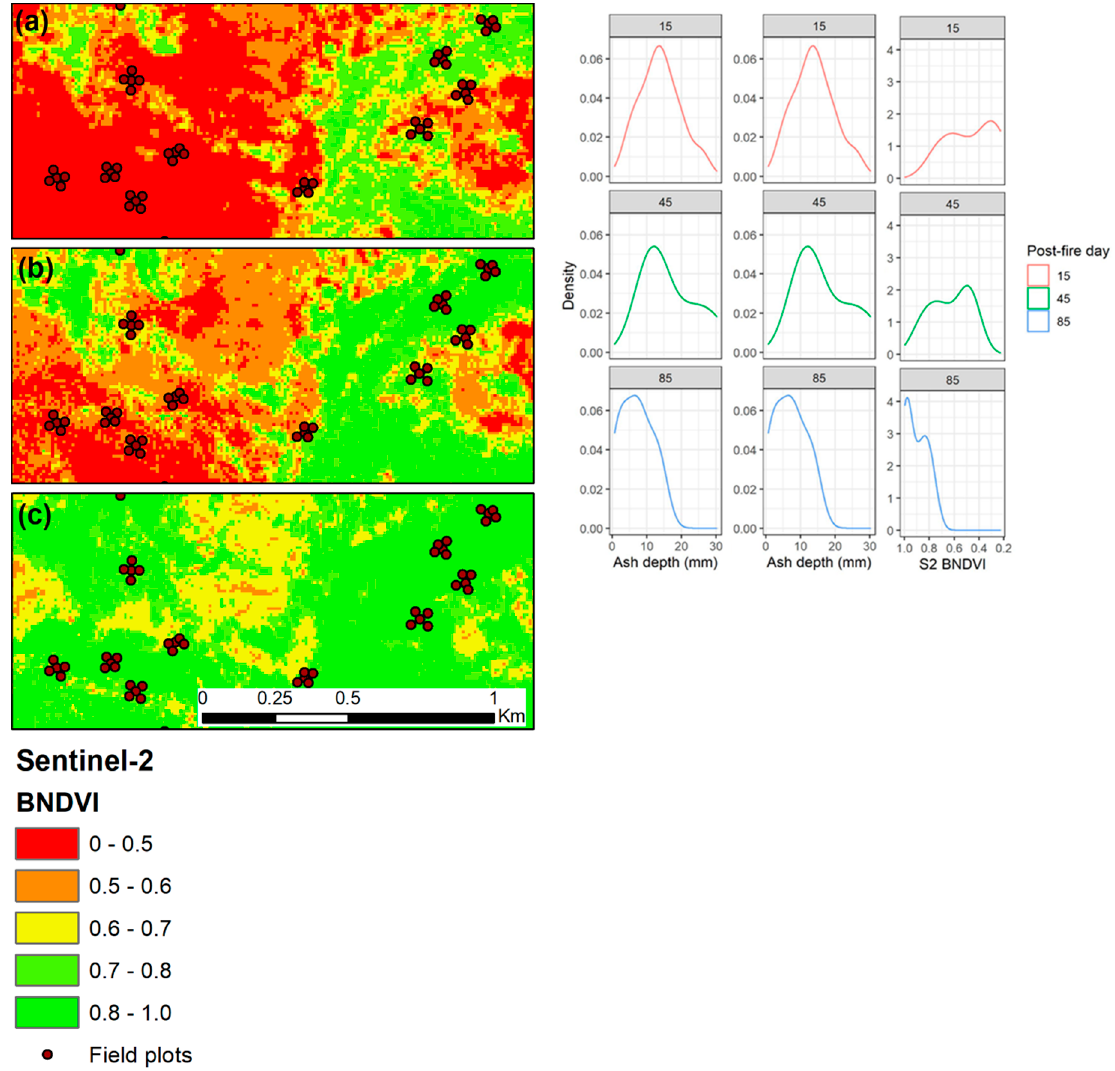
Figure 14. Comparing three classified Sentinel-2 BNDVI images from the Mesa Fire by post-fire days 15 ( a ), 45 ( b ) and 85 ( c ). The density plots represent the distribution of field data: ash cover, ash depth, and S2 BNDVI values at the three dates. The x-axis was inversed on the BNDVI graph to visually correspond with the change in ash cover and depth over time. Table 4. Results of the linear mixed-effects model (Ash cover = BNDVI ◦ post-fire day ◦ burn severity). Significant differences in the least-squared means between the post-fire day and severity groups are indicated by different letter groups ( p <